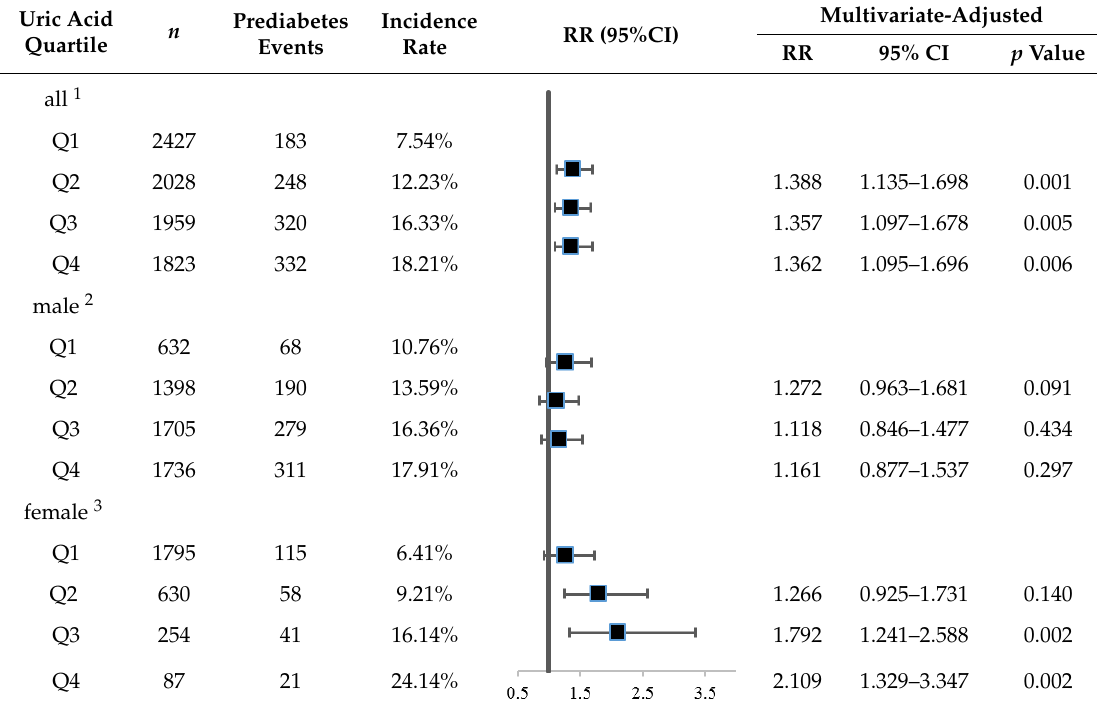
Table 2. Results of generalized estimating equation (GEE) analysis for serum uric acid (SUA) and prediabetes with their relative risks (RRs) and 95% confidence intervals (CIs).